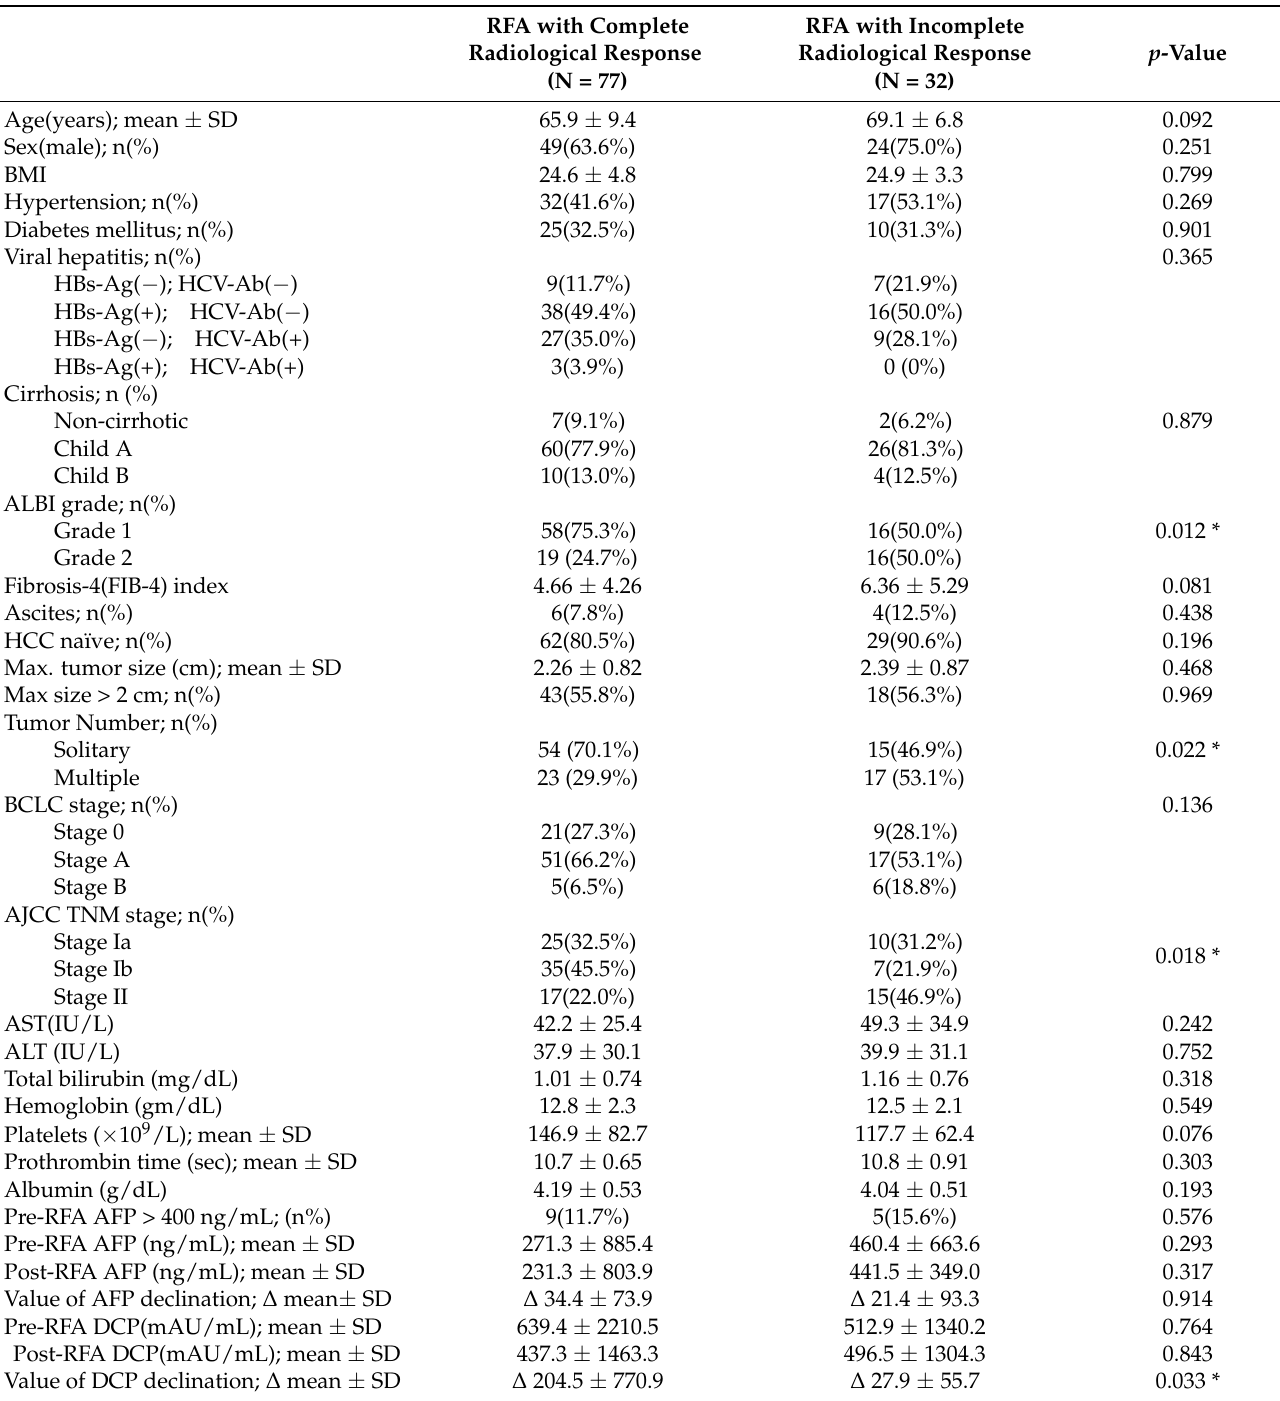
Table 1. Baseline characteristics of 109 patients with radiofrequency ablation therapies (RFA) for hepatocellular carcinoma according to the radiological response at 1 month post